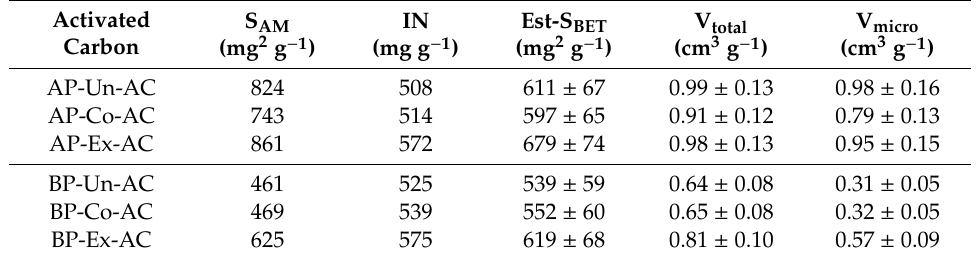
Table 4. Textural characterization parameters of the activated carbons from piassava with di ff erent